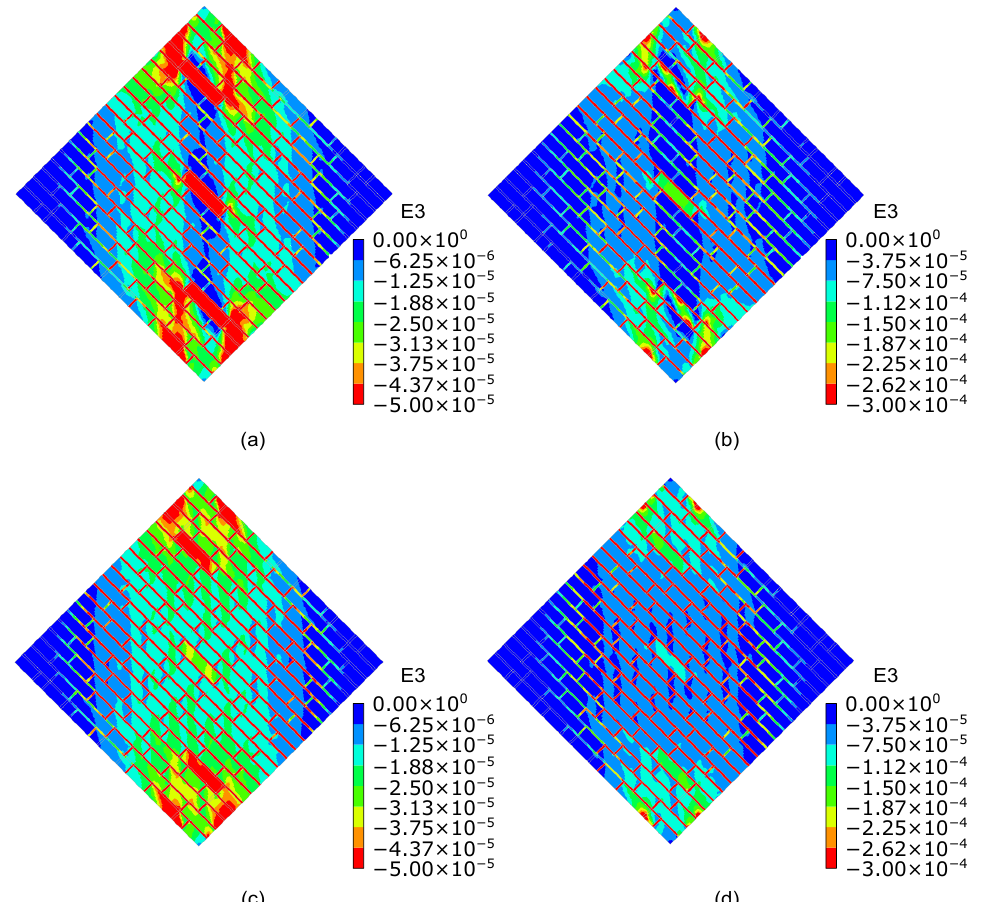
Figure 9. Compressive strain fields obtained from the numerical simulations (E3 denotes the com- pressive principal strain): ( a ) Strain state of specimen A at the one-third of peak shear stress; ( b ) strain state of specimen A at the peak shear stress; ( c ) strain state of specimen B at the one-third of peak shear stress; ( d ) strain state of specimen B at the peak shear